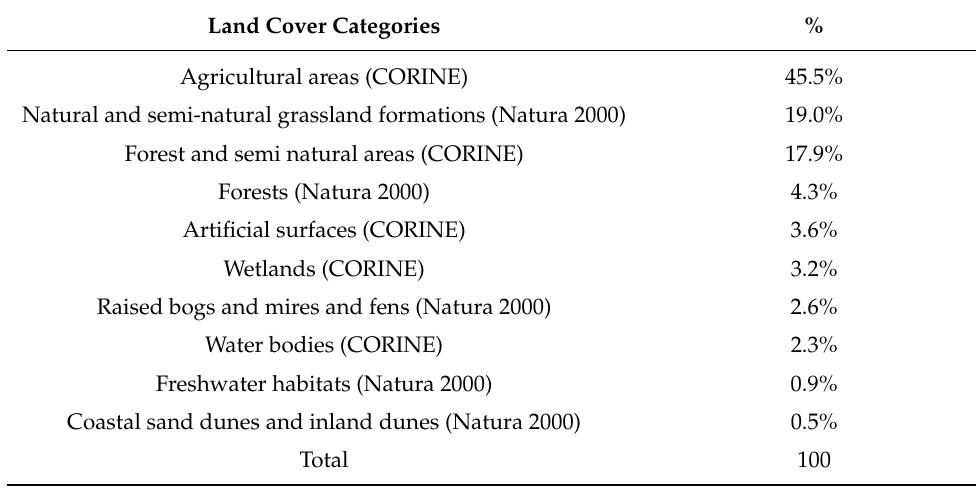
Table 1. Distribution of land cover categories in the terrestrial part of the study area according to the compiled